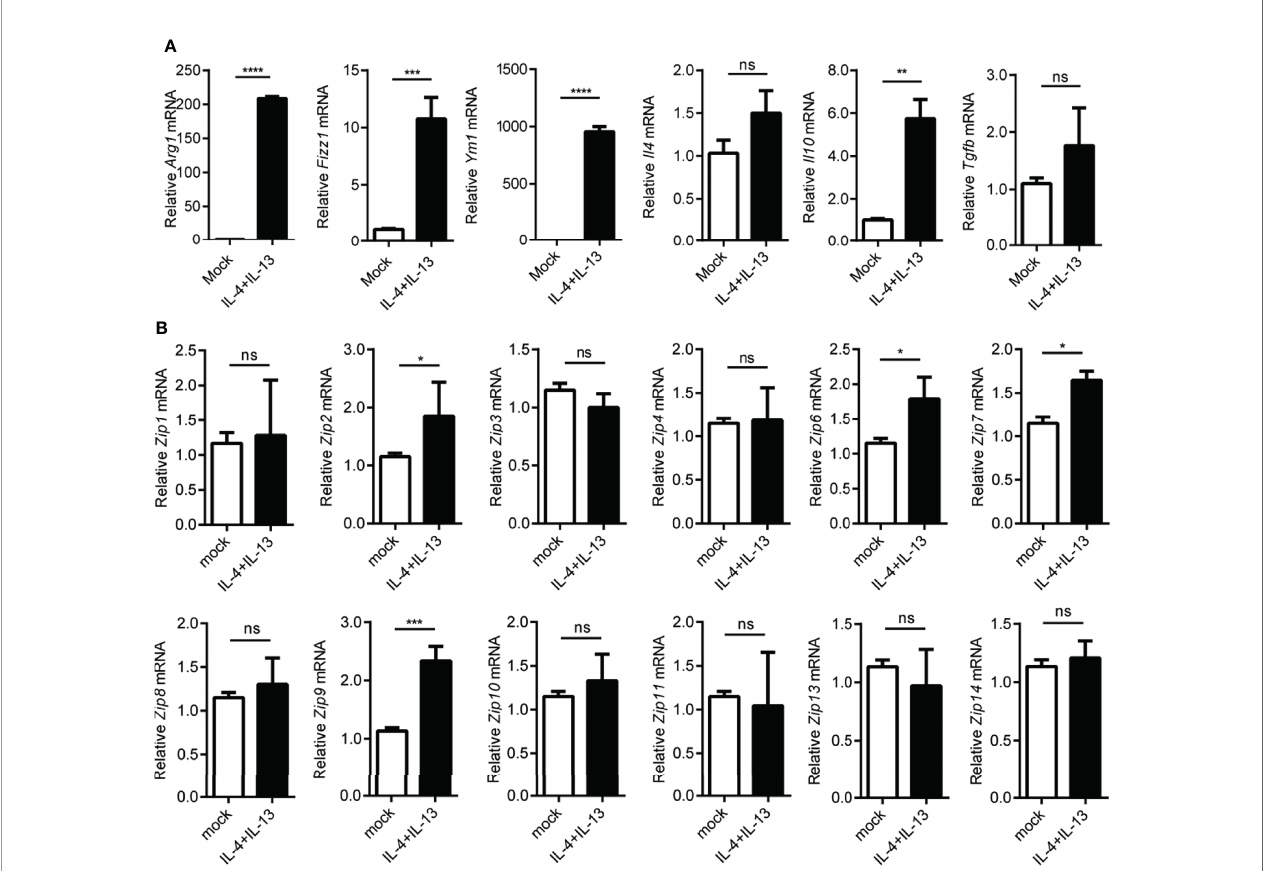
FIGURE 5 | Transcription of Zip9 is upregulated during M2 macrophage polarity. (A) The mRNA levels of Arg1 , Ym-1 , Fizz1 , and Il10 , Il4 , Tgfb were detected in IL-4 and IL-13 (20 ng/ml each) stimulated M2-polarized macrophages. (B) Zip s transcription was detected by RT-PCR. PEMs were stimulated with IL-4 and IL-13 for 24 h. Data are shown as means ±S.D (n=4). Data were normalized for b -actin mRNA levels. A, B was analyzed by two-tailed Student ’ s t-test. The representative data from three independent experiments are shown. P values are as followed: * P < 0.05, ** P < 0.01, *** P < 0.001 and **** P < 0.0001, ns, not signi fi